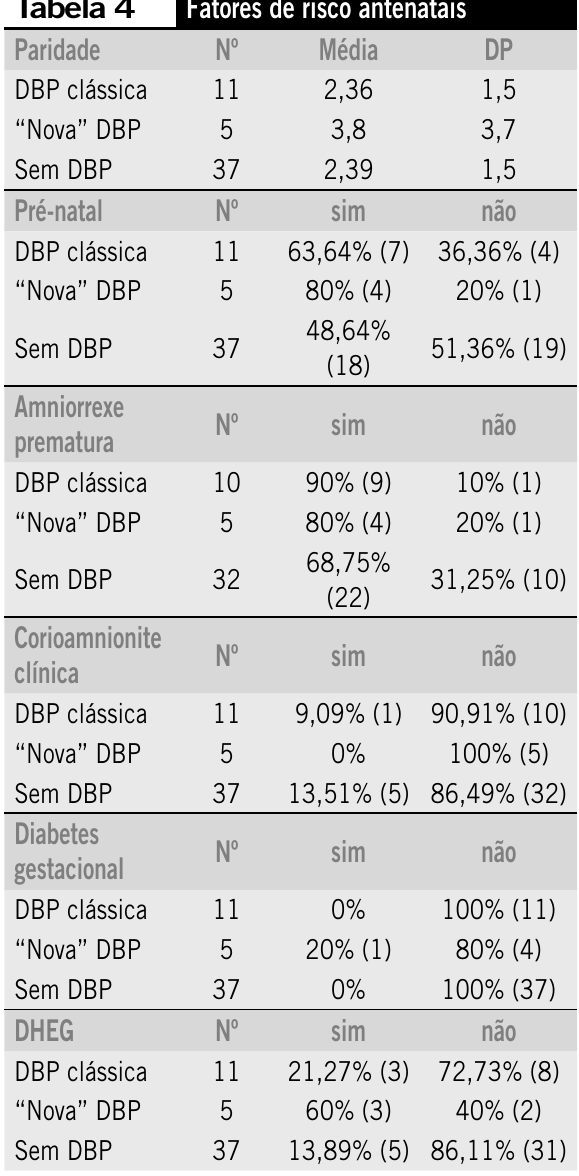
Dados sem significância estatística ( p > 0.017). DP: desvio padrão; DBP: displasia broncopulmonar; DHEG: doença hipertensiva específica da